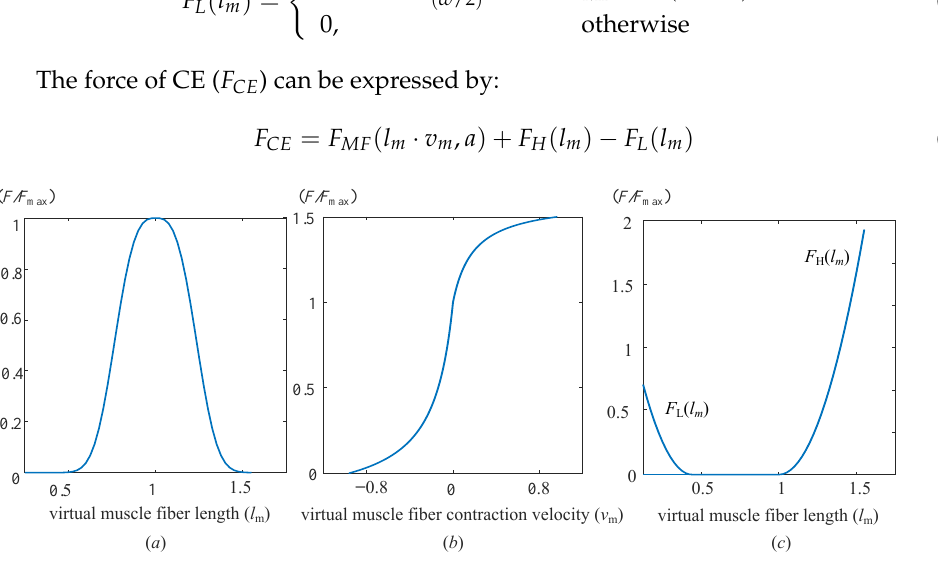
Figure 3. Contractiondynamics of the CE. ( a ) Force–length relationship (Equation (2)). ( b ) Force– velocity relationship (Equation (3)). ( c ) Parallel elastic component force (Equations (4) and